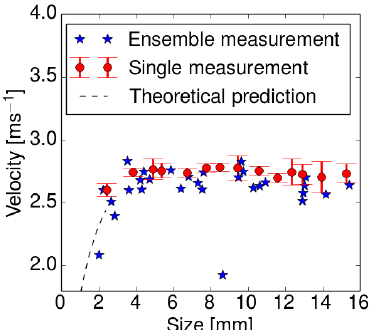
Figure 12. Comparison of velocity measurements of single Styro- foam objects (dropped one after the other) and of the whole ensem- ble (all particles dropped at the same time from the same height).